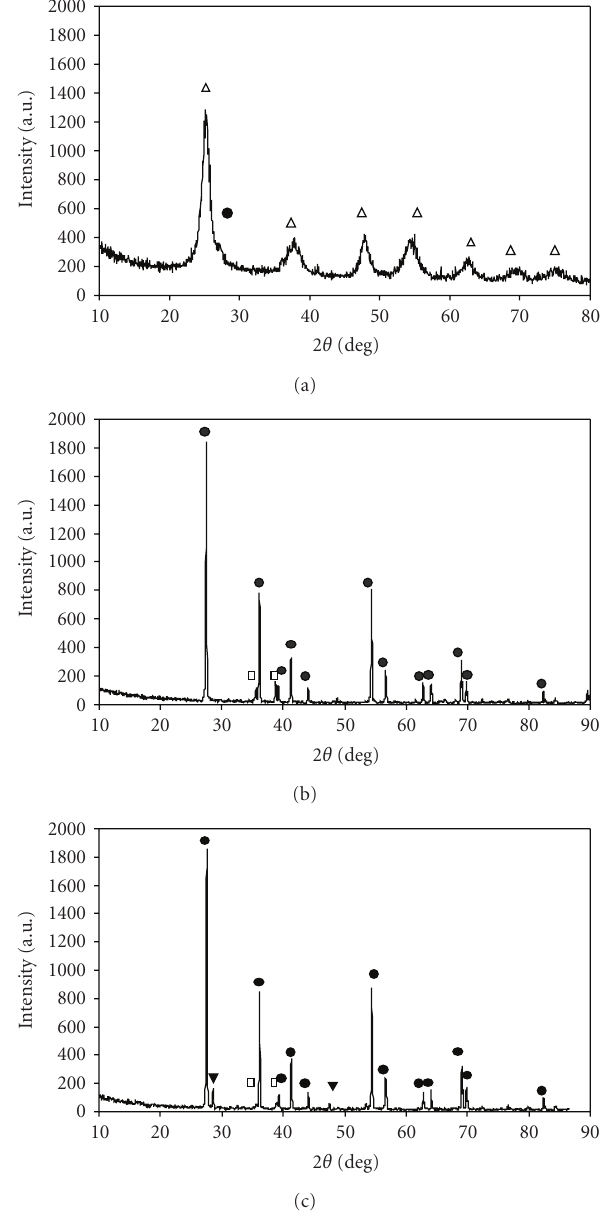
Figure 1: XRD patterns of crude TiO 2 and Cu-modified photocat- alysts: (a) crude TiO 2 ; (b) photocatalyst containing 10wt% Cu; (c) photocatalyst containing 20wt% Cu. • -rutile; Δ -anatase; (cid:2) -CuO; (cid:3) -CuCl.